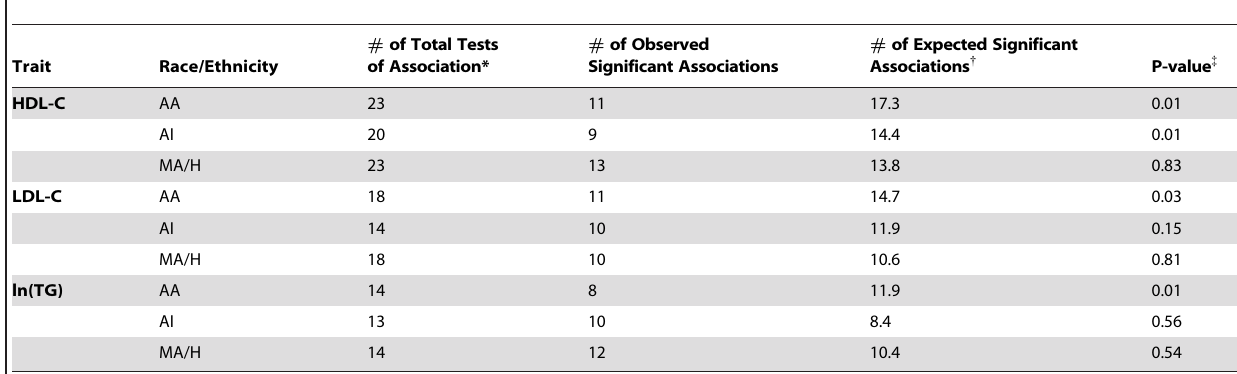
Table 5. Observed versus expected number of significant associations, by trait and